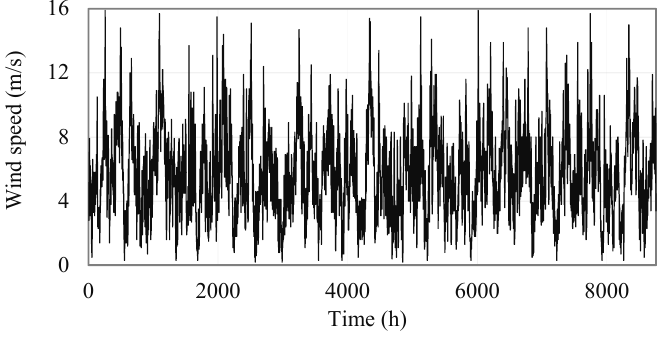
Figure 3. One year profile of hourly wind speed data in Okinawa.